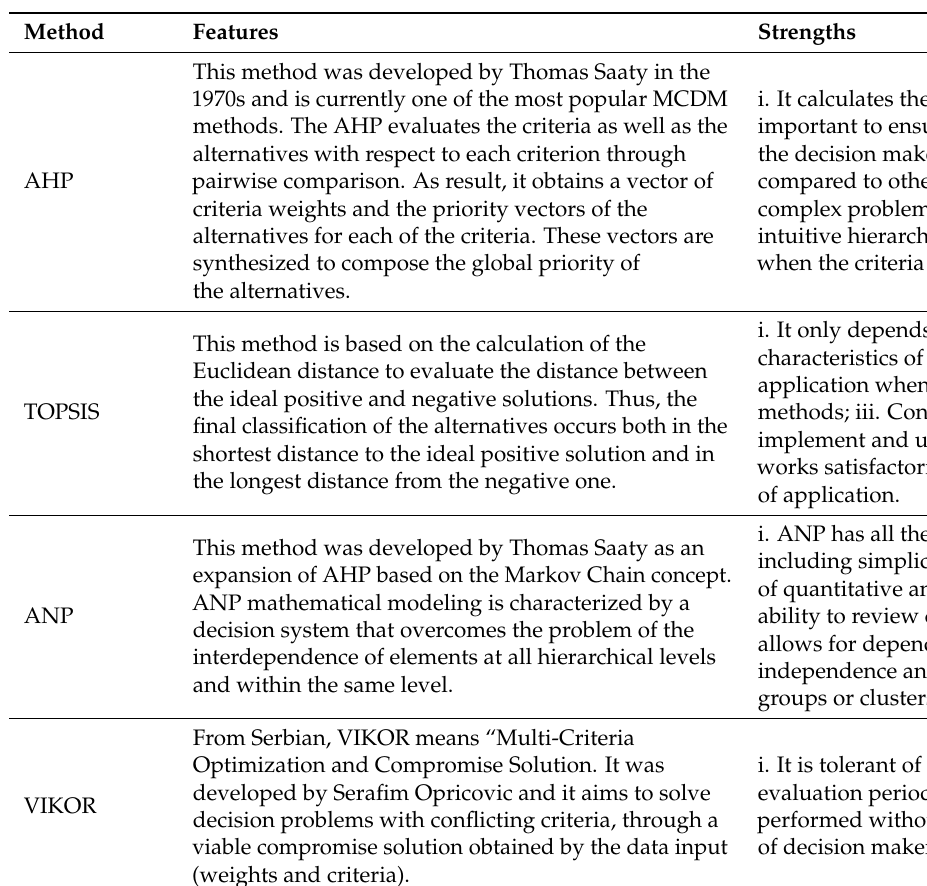
Table 2. Overview of the main MCDM methods in the